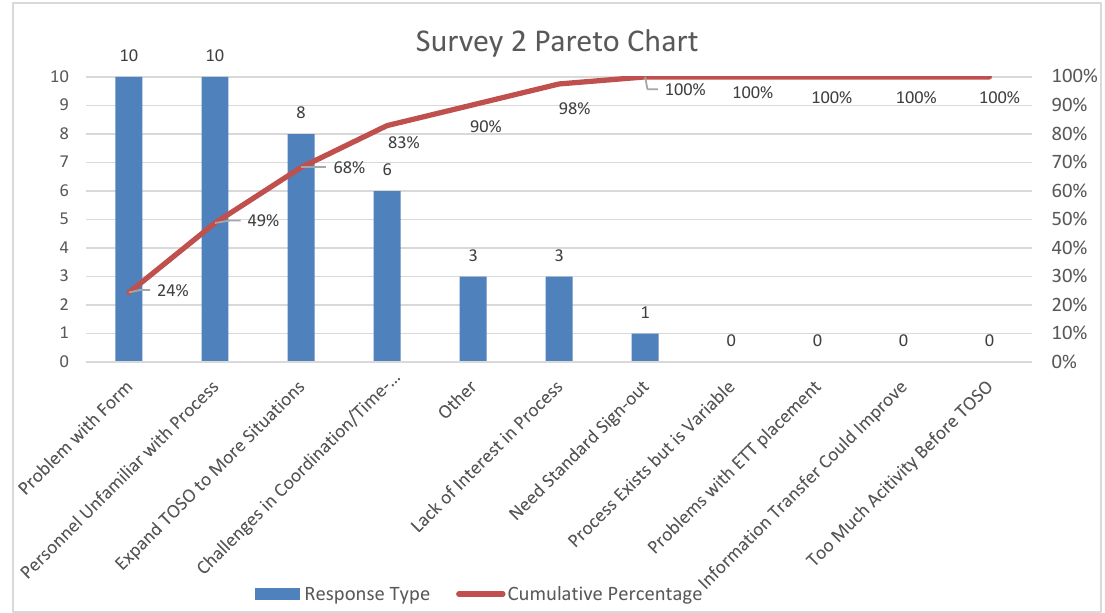
Figure 3. Pareto chart for comments from providers—Survey 1(pre-implementation survey).